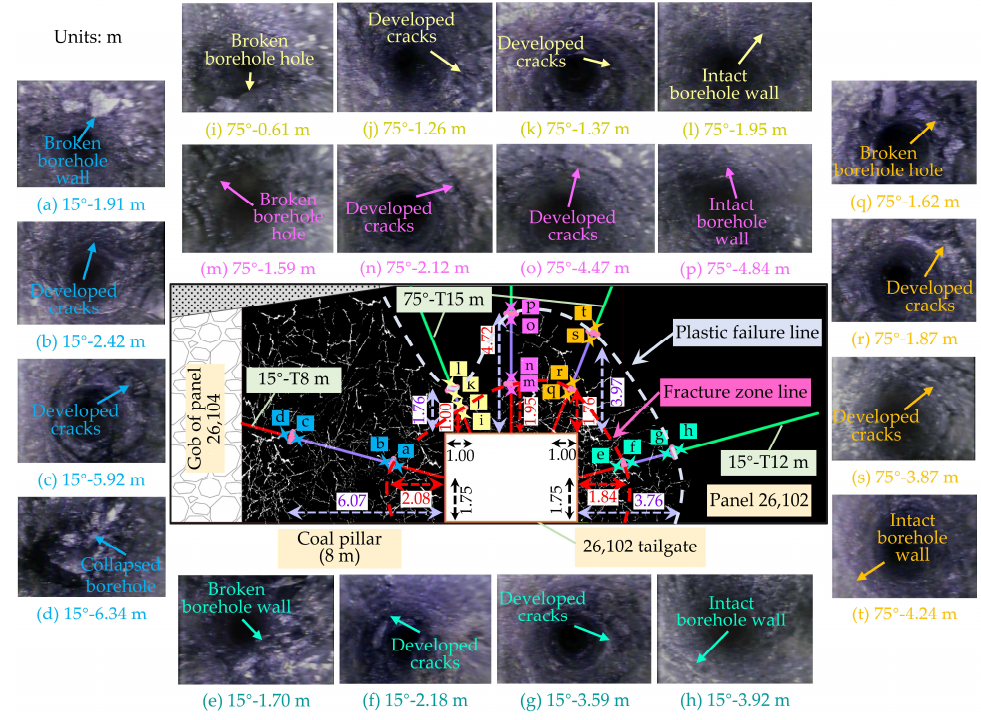
Figure 12. Borehole-scoping for the coal body in 26,102 tailgate.